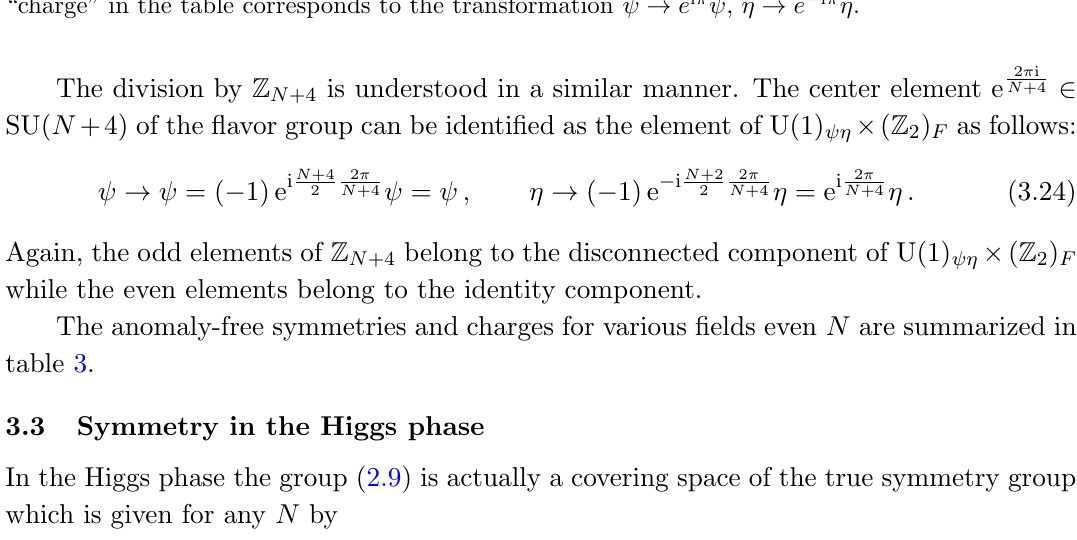
Table 3 . The charges of various (cid:12)elds with respect to the unbroken symmetry groups for even N . B AB are the possible massless composite fermion (cid:12)elds discussed in section 2.1. The ( Z 2 ) F \charge" in the table corresponds to the